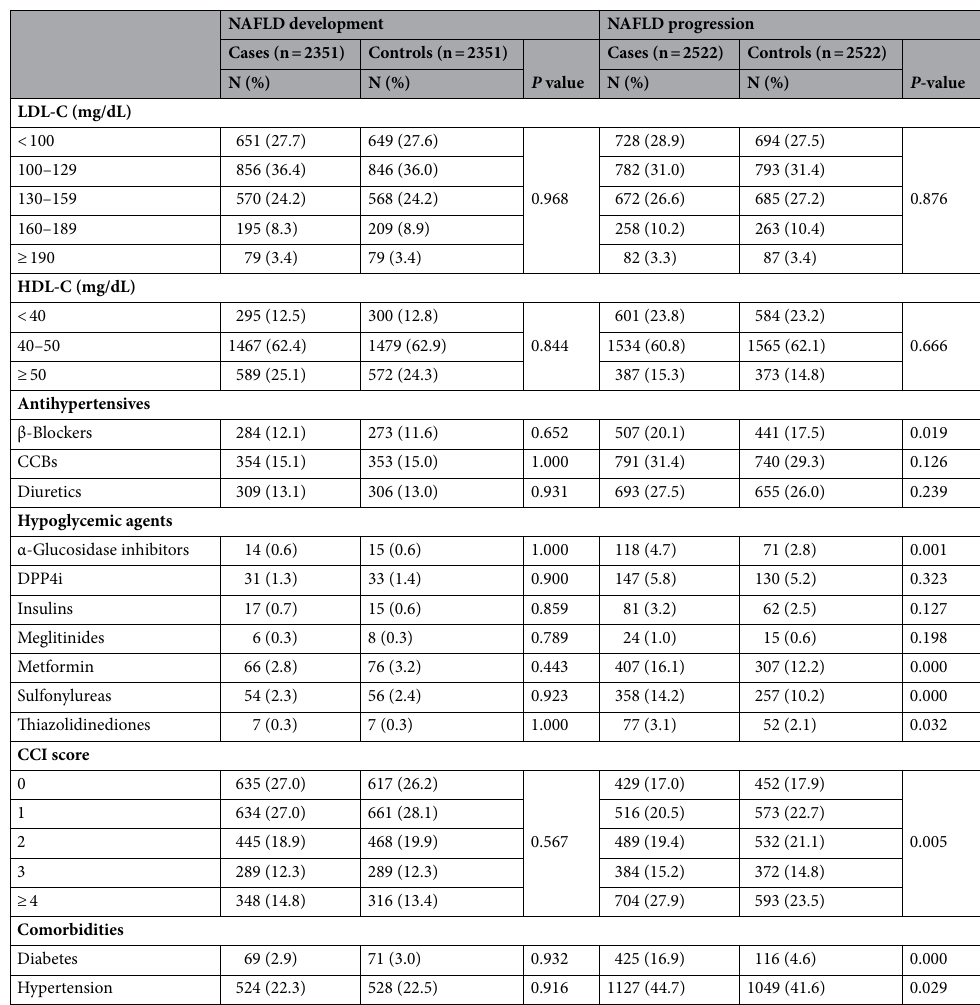
Table 1. Baseline characteristics of cases and controls after propensity score matching. a < 7 drinks per week for women, < 14 drinks per week for men. b Moderate intensity activity ≥ 150 min per week, or